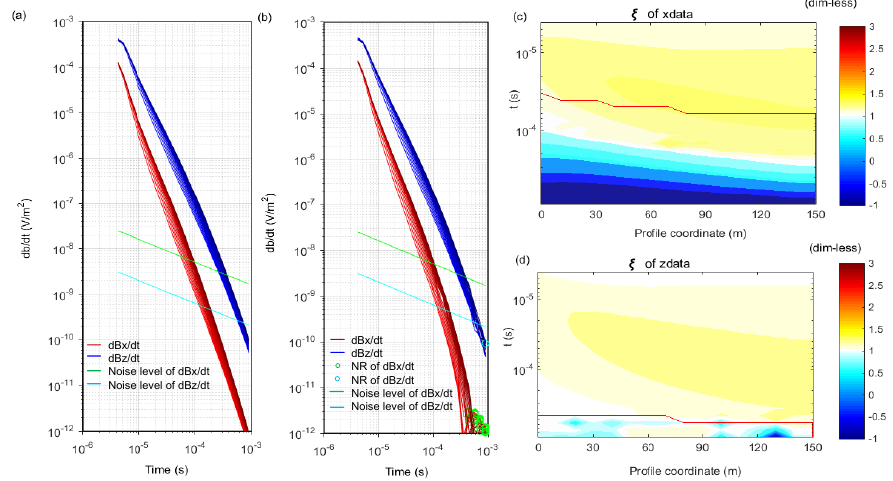
Figure 6. Results of forward modeling for the subtle chargeable medium: ( a ) non-IP responses and ( b ) IP responses; ( c ) ξ of x -component; and ( d ) ξ of z -component. The meanings of the curves and area are the same as in Figure 4.